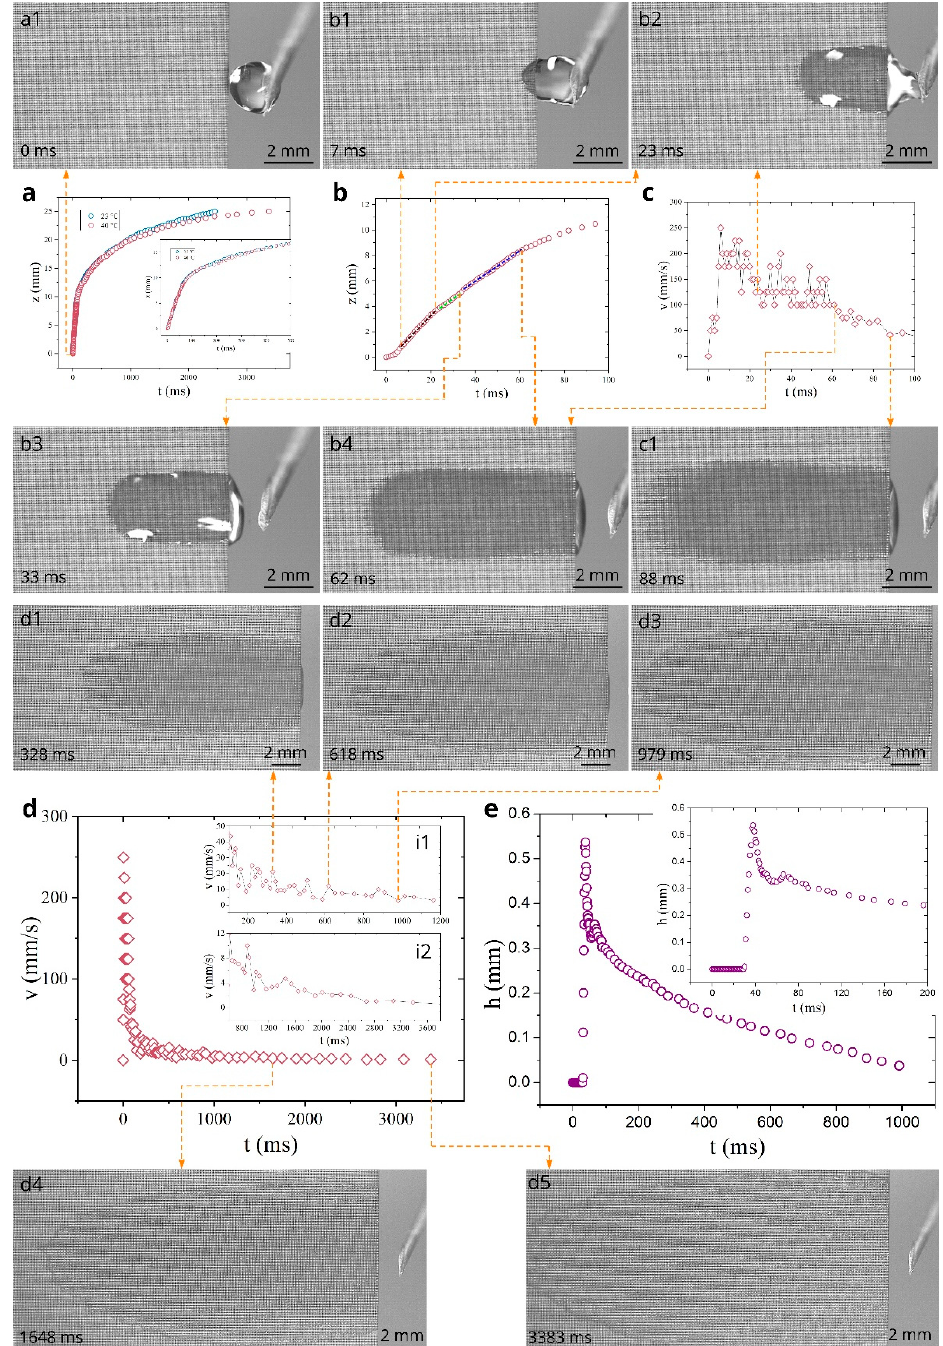
Figure 4. Dependences z ( t ), v ( t ), and h ( t ) at 40 °C and snapshots of water spreading (experiment was performed 74 days after laser processing of the sample). ( a ) The overall plot of the spreading distance as a function of time and its comparison with that at 23 °C. ( b ) Detailed z ( t ) plot between 0 and 100 ms. The dashed lines show three z ∝ t substages. ( c ) Plot of the velocity as a function of time between 0 and 100 ms. ( d ) The overall plot of the velocity as a function of time. ( e ) Plot of water film thickness as a function of time at z = 4 mm.